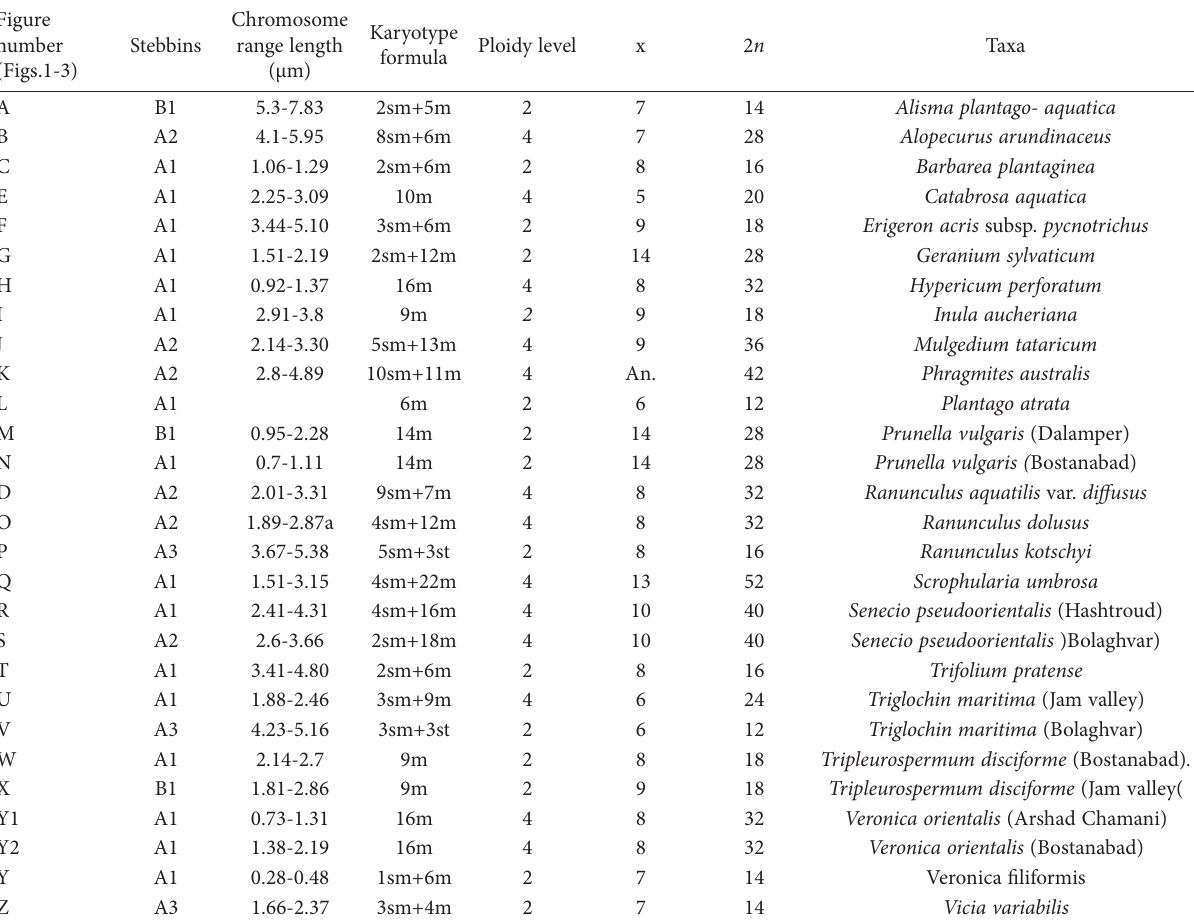
Table 3. Somatic chromosome number (2n), Ploidy level, karyotype formula, ranges of chromosome length and degree of Asymmetry according to STEBBINS (1971) for the studied taxa, Figure numbers are related images in Fig